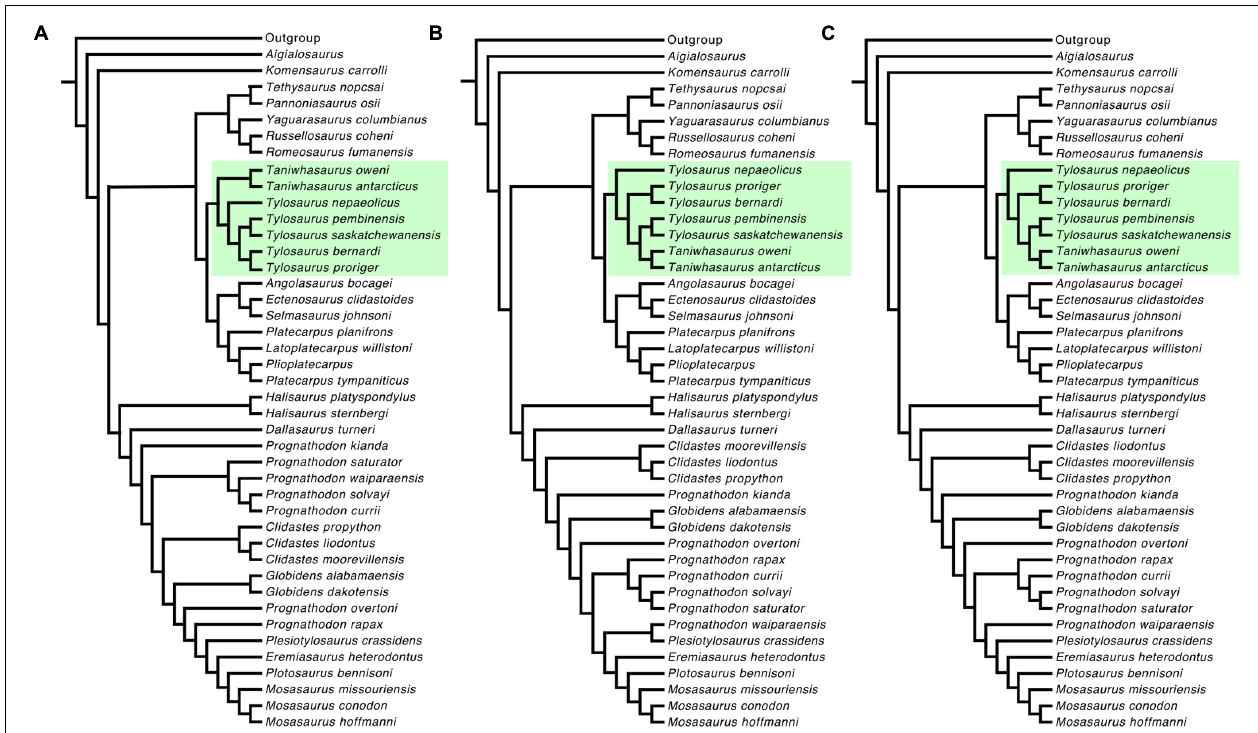
FIGURE 3 | Majority Rule Consensus trees from the Implied Weight analysis, using the reduced data set: (A) Majority Rule Consensus tree of the single best tree of 32.985 fit score and 437 steps, K = 5 (C.I. = 0.3616; R.I. = 0.7243); (B) Majority Rule Consensus tree of the single best tree of 20.41 fit score and 435 steps, K = 10 (C.I. = 0.3632; R.I. = 0.7263); (C) Majority Rule Consensus tree of the single best tree of 14.84 fit score and 435 steps, K = 15 (C.I. = 0.3632; R.I. =